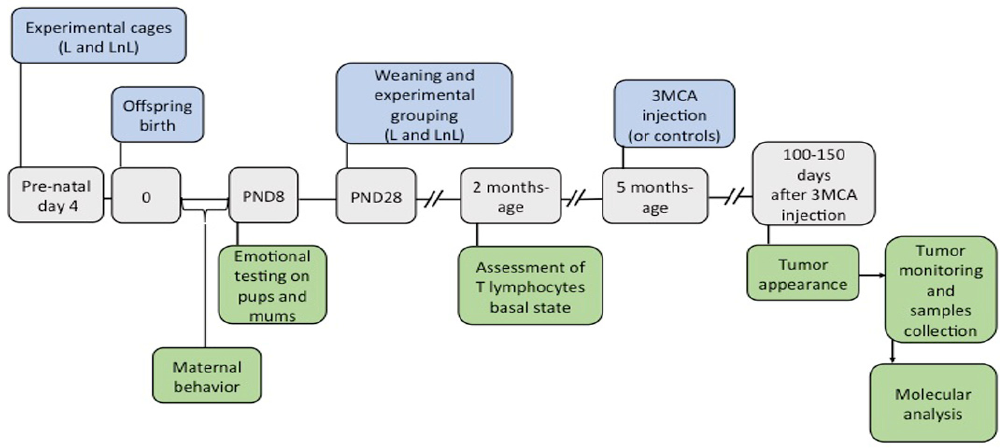
Figure 1. Experimental design and groups. Top panels : experimental manipulations are shown in blue and include: 1. grouping pregnant females in L and LnL cages four days before offspring birth; 2. weaning at postnatal day 28 (PND28) during which male mice were caged in groups of four made of two pairs of siblings from two distinct L or LnL home-cages; 3. 3-methylcolantrene injection in the right rear leg of 8 L and 8 LnL mice (the same number of mice from the two groups were left undisturbed and used as controls). Middle panels: temporal timeline for the experiments, with gray boxes indicating key time points. Bottom panels: measured variables are reported in green boxes and include: 1. assessment of maternal behavior during the first week of pups’ life; 2. pups’ ultrasonic vocalizations and anxiety behavior measured on biological mothers on the elevated plus maze on PND8; 3. assessment of T lymphocytes basal state; 4. tumor monitoring from their onset until sacrifice; 5. molecular analysis on tumor and muscle samples.